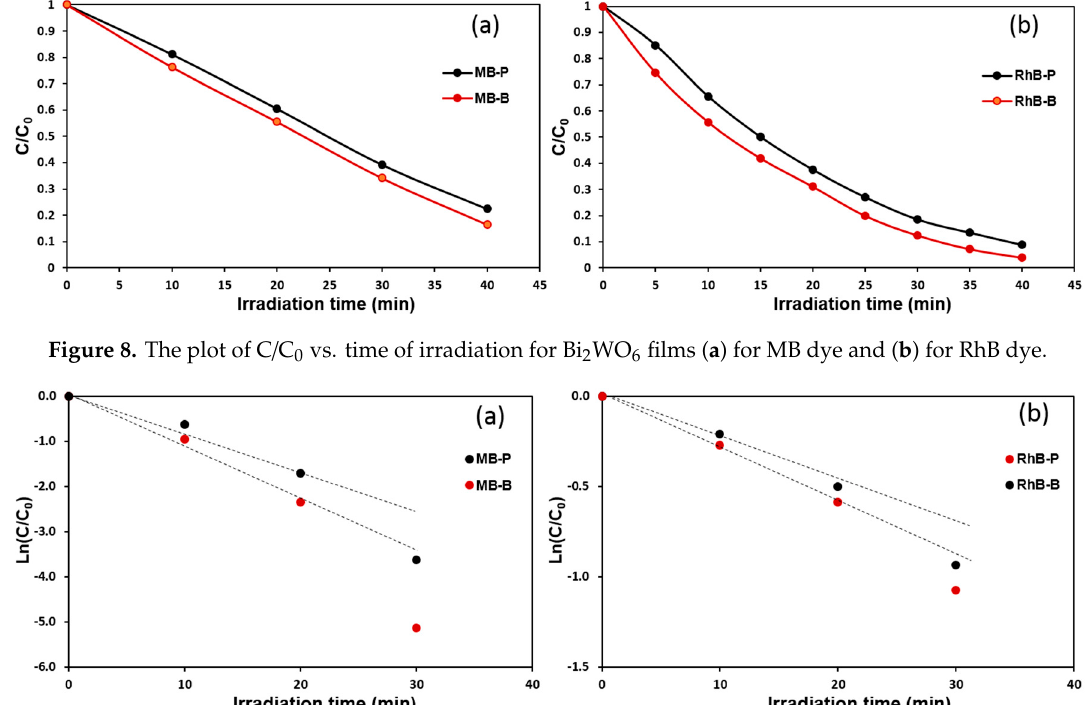
Figure 9. Kinetic plot of Ln(C / C 0 ) vs. time of irradiation for photocatalytic degradation of ( a ) MB dye and ( b ) with RhB dye.